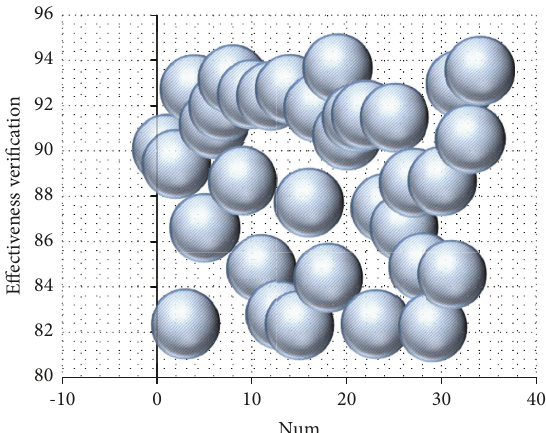
Figure 10: Statistical diagram of the effect of smart city construction.